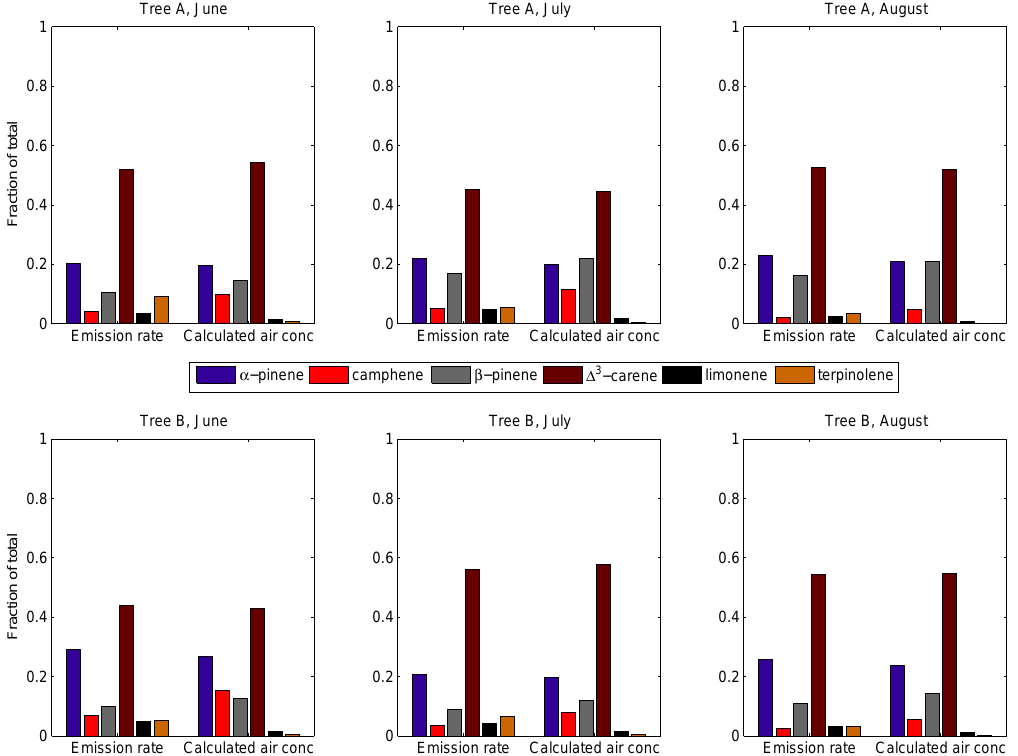
Fig. 7. Relative emission rates of monoterpenes: 1 3 -carene, α -pinene, β -pinene, terpinolene, camphene, limonene and p-cymene, and their calculated air concentrations due to oxidation with OH and